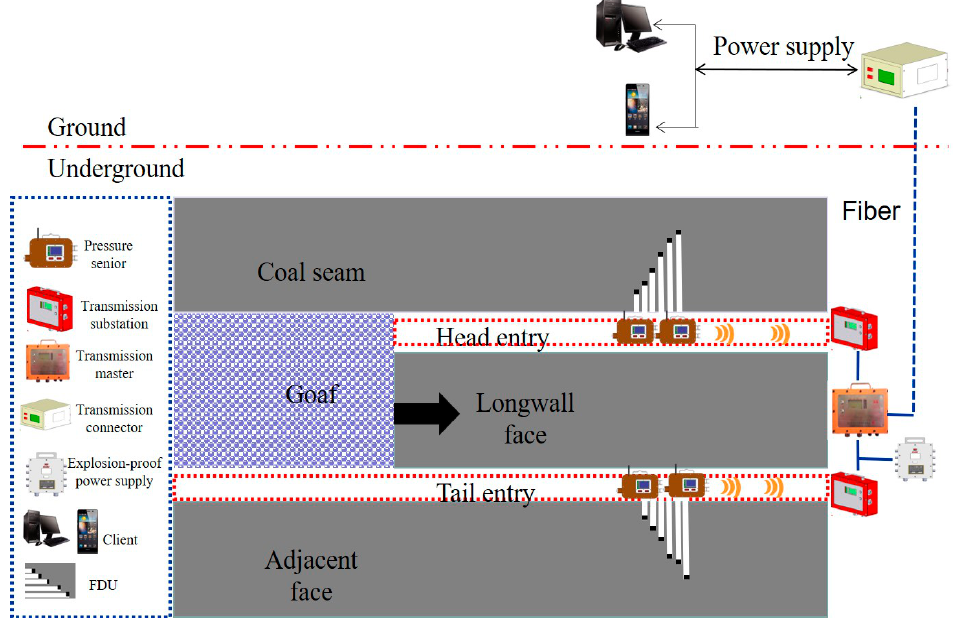
Figure 4. Working principle of the abutment pressure monitoring